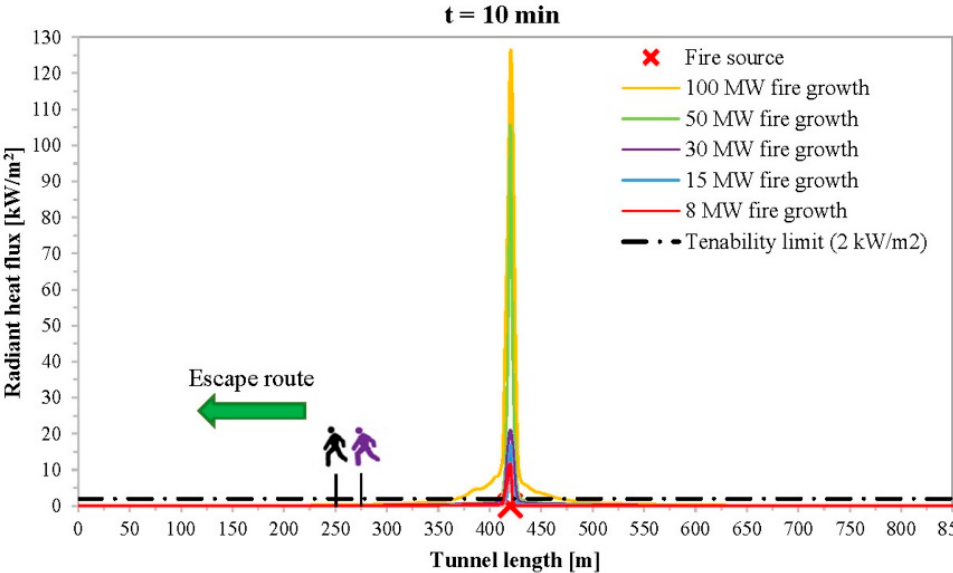
Figure 7. Profiles of longitudinal radiant heat flux at a height of 2 m along the escape route on the road carriageway after 10 min from the fire’s start when the burning vehicle is at 420 m from portal A.